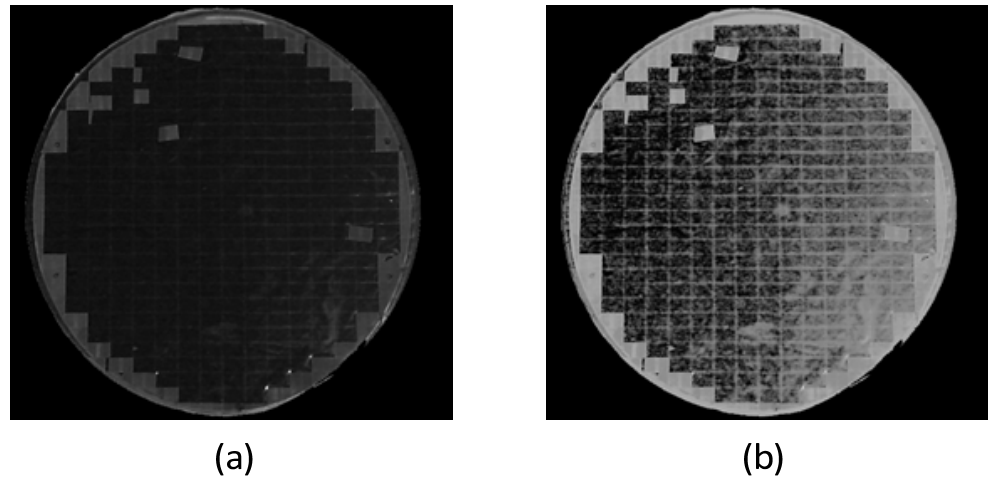
Figure 9. ( a ) The grayscale image obtained from Figure 3b; ( b ) the enhanced image (cid:1857)((cid:1876), (cid:1877)) obtained by applying the histogram equalization on Figure 9a.